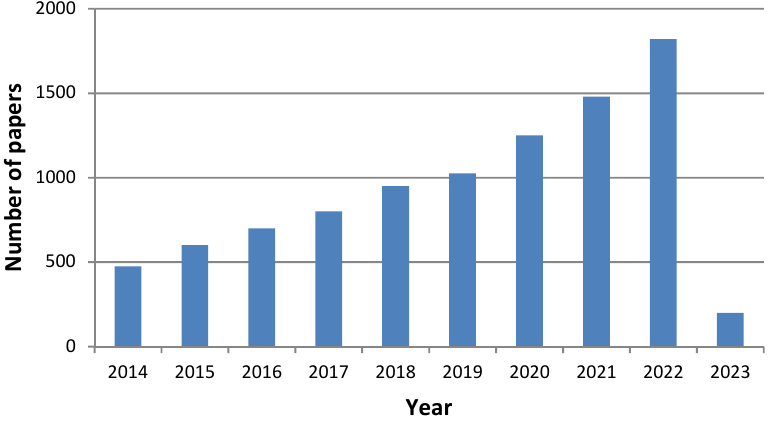
Figure 1. Publications on synthesis of biofuels from terpenes.